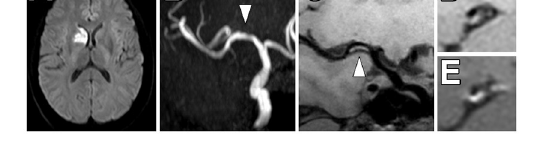
FIGURE6 Non-stenotic right middle cerebral artery enhancing culprit plaque. (A) A patient with a right basal ganglia acute infarct showed (B) mild luminal irregularity but no appreciable stenosis of the right middle cerebral artery on time-of-flight MRA imaging (arrowhead). (C) Precontrast VW-MRI showed eccentric wall thickening along the right M1 middle cerebral artery (arrowhead). (D) Precontrast and (E) postcontrast images in the orthogonal plane through the plaque shows eccentric wall thickening and enhancement of the culprit plaque, which likely caused the ischemic